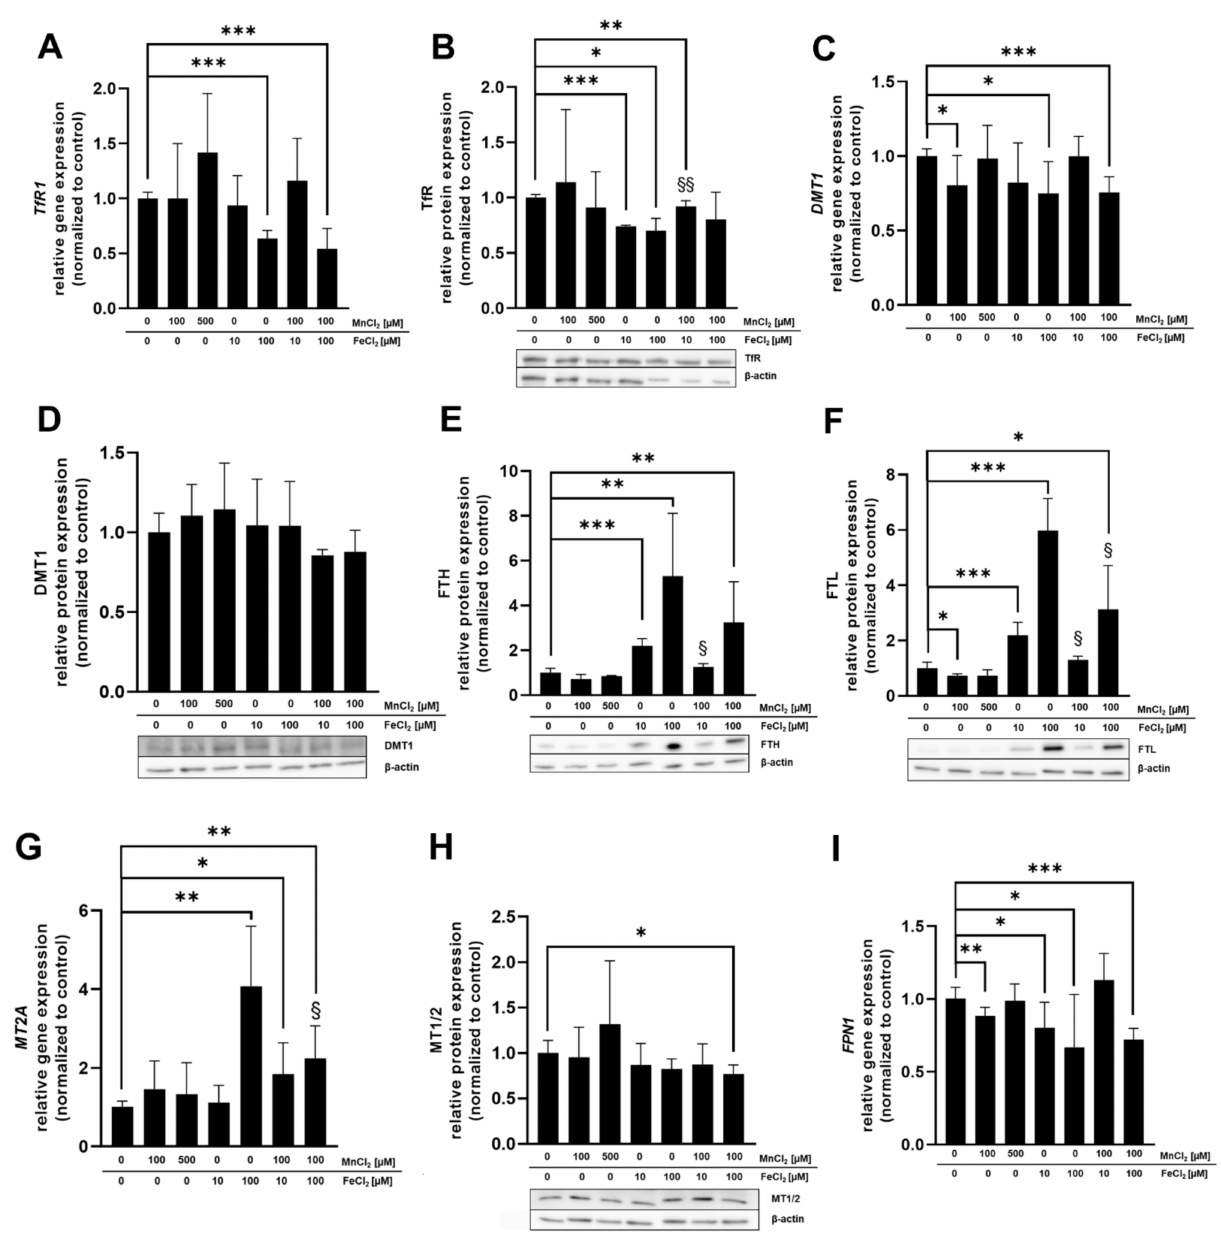
Figure 5. Relative mRNA and protein levels of Mn and Fe transport- and storage-associated genes and their respective proteins. ( A ) TfR1 relative gene expression. ( B ) TfR relative protein expression. ( C ) DMT1 relative gene expression. ( D ) DMT1 relative protein expression. ( E ) FTH relative protein expression. ( F ) FTL relative protein expression. ( G ) MT2A relative gene expression. ( H ) MT1/2 relative protein expression. ( I ) FPN1 relative gene expression. Confluent BeWo b30 cells were incubated with MnCl 2 and/or FeCl 2 for 24 h. Relative gene expression was determined using RT- qPCR and normalized to ACTB ( β -actin) as the housekeeping gene. Protein quantification via